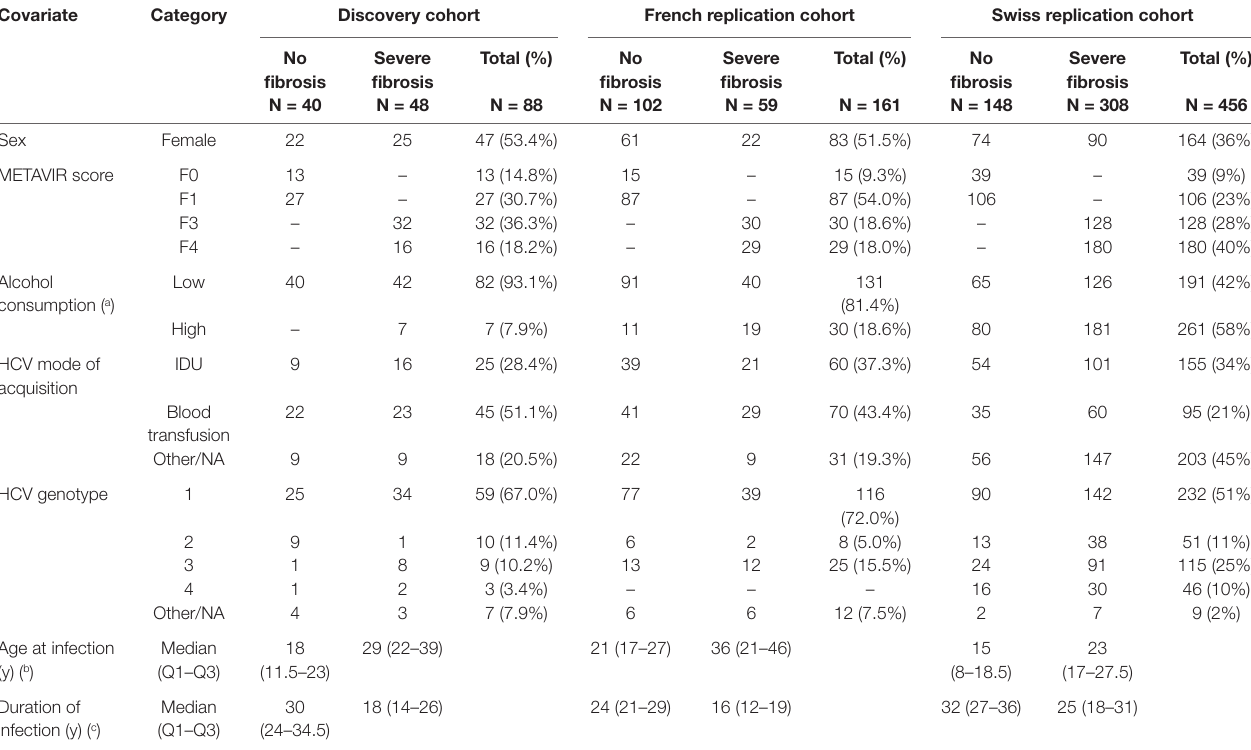
TABLE 1 | Clinical and demographic characteristics of chronically HCV infected patients of the discovery cohort (N = 88), the French replication cohort (N = 161), and the Swiss replication cohort (N = 453).